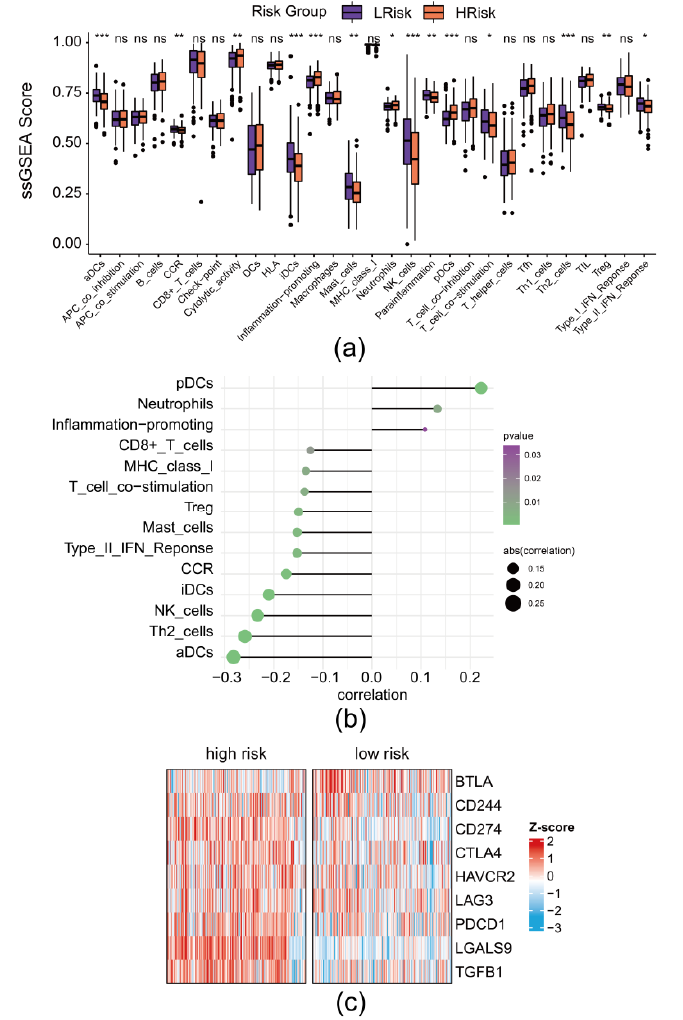
Figure 7. The risk model revealed the remodeling of immune landscape in DLBCL: ( a ) Comparison of immune components in DLBCL between the low-risk and high-risk groups; aDC stands for activating Dendritic Cells; iDCs stands for immature Dendritic Cells; pDCs stands for plasmacytoid Dendritic Cells; Tfh stands for Follicular helper T cell; CCR stands for Chemokine receptors; TIL stands for Tumor Infiltrating Lymphocytes; Treg stands for regulatory T cells; *: p < 0.05; **: p < 0.01; ***: p < 0.001; ( b ) Correlation between immune components in DLBCL and high-risk scores; ( c ) Heatmap of co-inhibitory factors in DLBCL between the low-risk and high-risk groups .